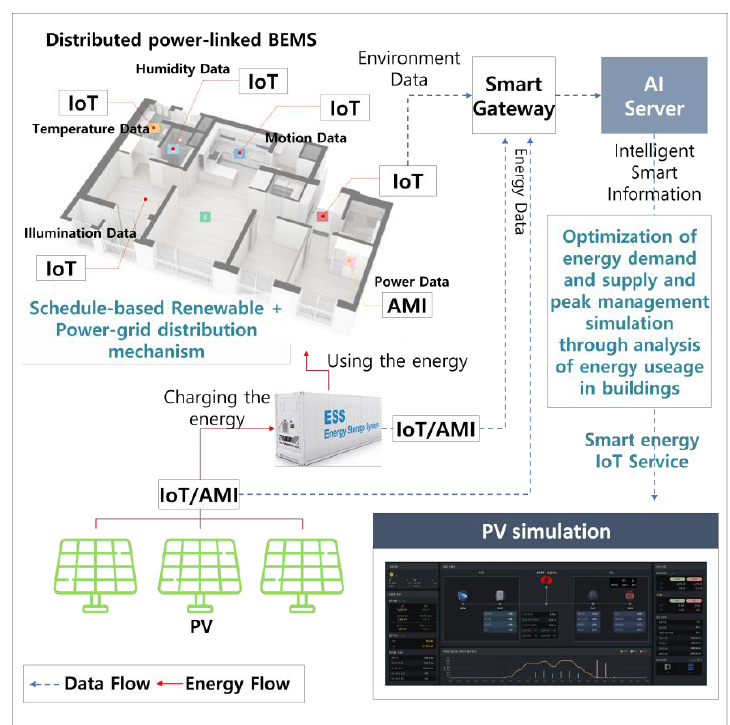
Figure 6. Construction of PV and ESS domain.